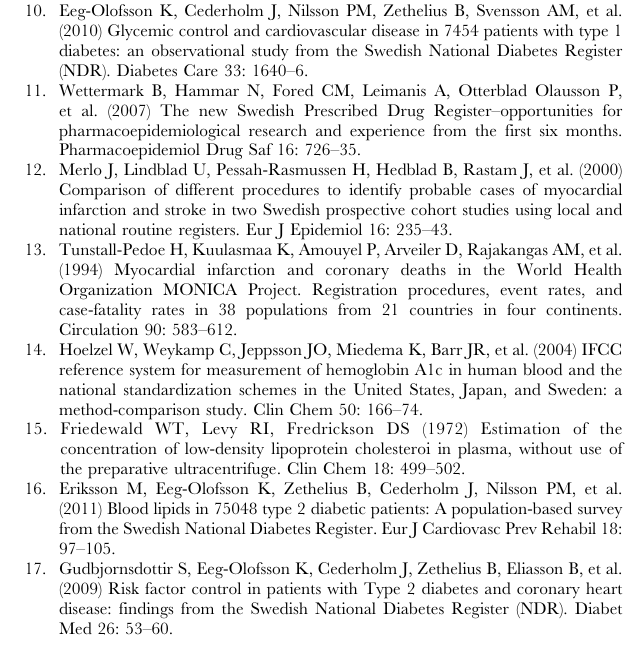
Table S1 Blood lipid values and history of CVD and renal disease of the patients with type 1 diabetes on lipid lowering treatment